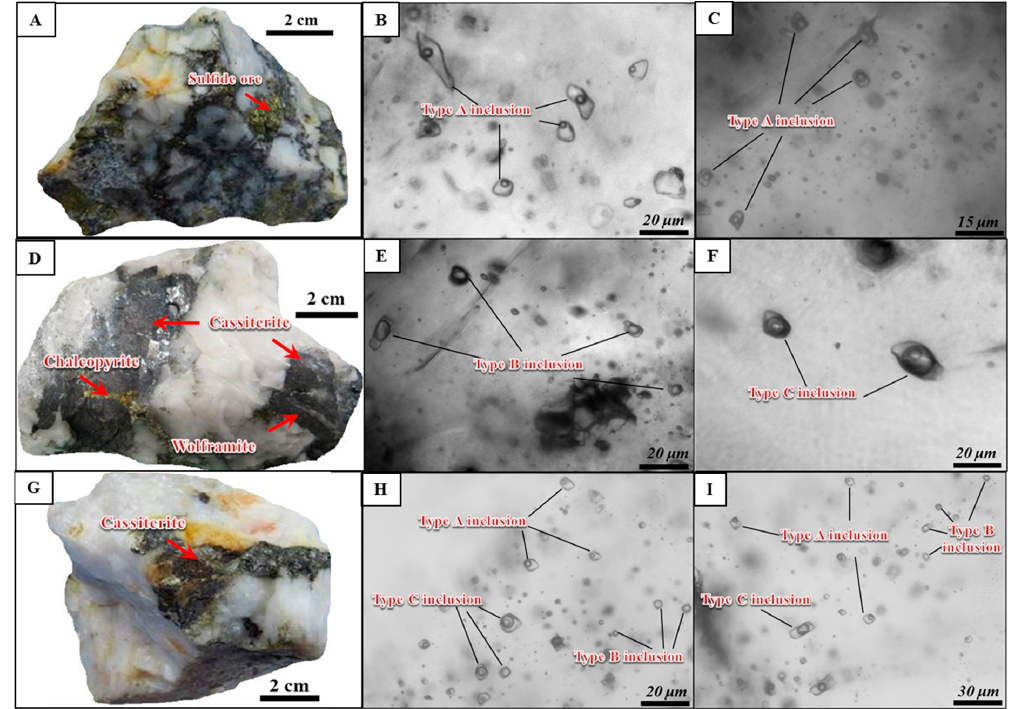
Figure 12. Photomicrographs of fluid inclusion types of the Tagu Sn–W deposit. ( A ). Sulfide-bearing quartz vein. ( B ). Type-A fluid inclusions in metasedimentary hosted quartz. ( C ). Type-A fluid inclusions in granite-hosted quartz. ( D ). Sn–W bearing quartz vein from granite rock. ( E ). Type-B fluid inclusions in the granite-hosted quartz. ( F ). Type-C fluid inclusions in granite-hosted quartz vein. ( G ). Sn–W bearing quartz vein from granite rock. ( H ). Type-A, B, and C fluid inclusions coexisting together within a small area in granite-hosted quartz. ( I ). Type-A, B, and C fluid inclusions coexisting together within a small area of the sample.